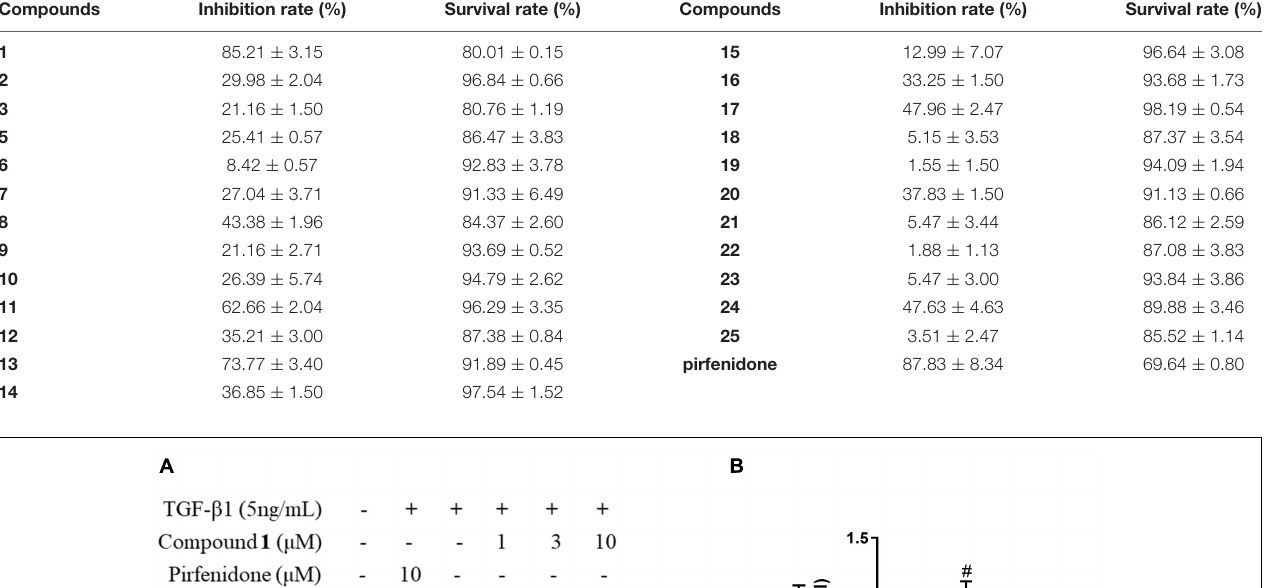
TABLE 2 | Collagen accumulation inhibition rate (IR) and cell survival rate (SR) of 1 – 3 , 5 – 25 . Compounds Inhibition rate (%) Survival rate (%) Compounds Inhibition rate (%) Survival rate (%)